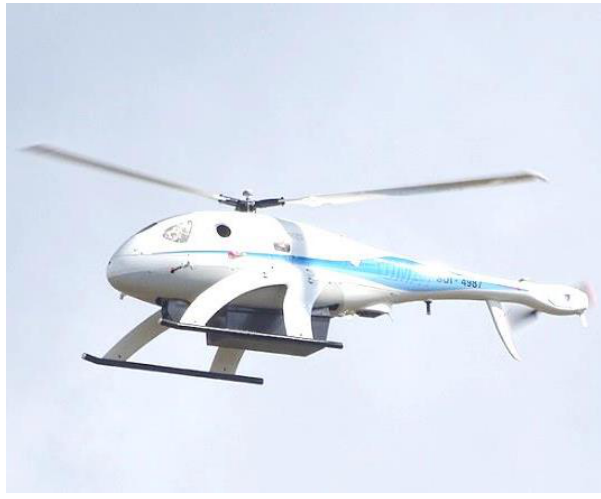
Fig. 1. UMS SKELDAR R-350 unmanned helicopter [25]